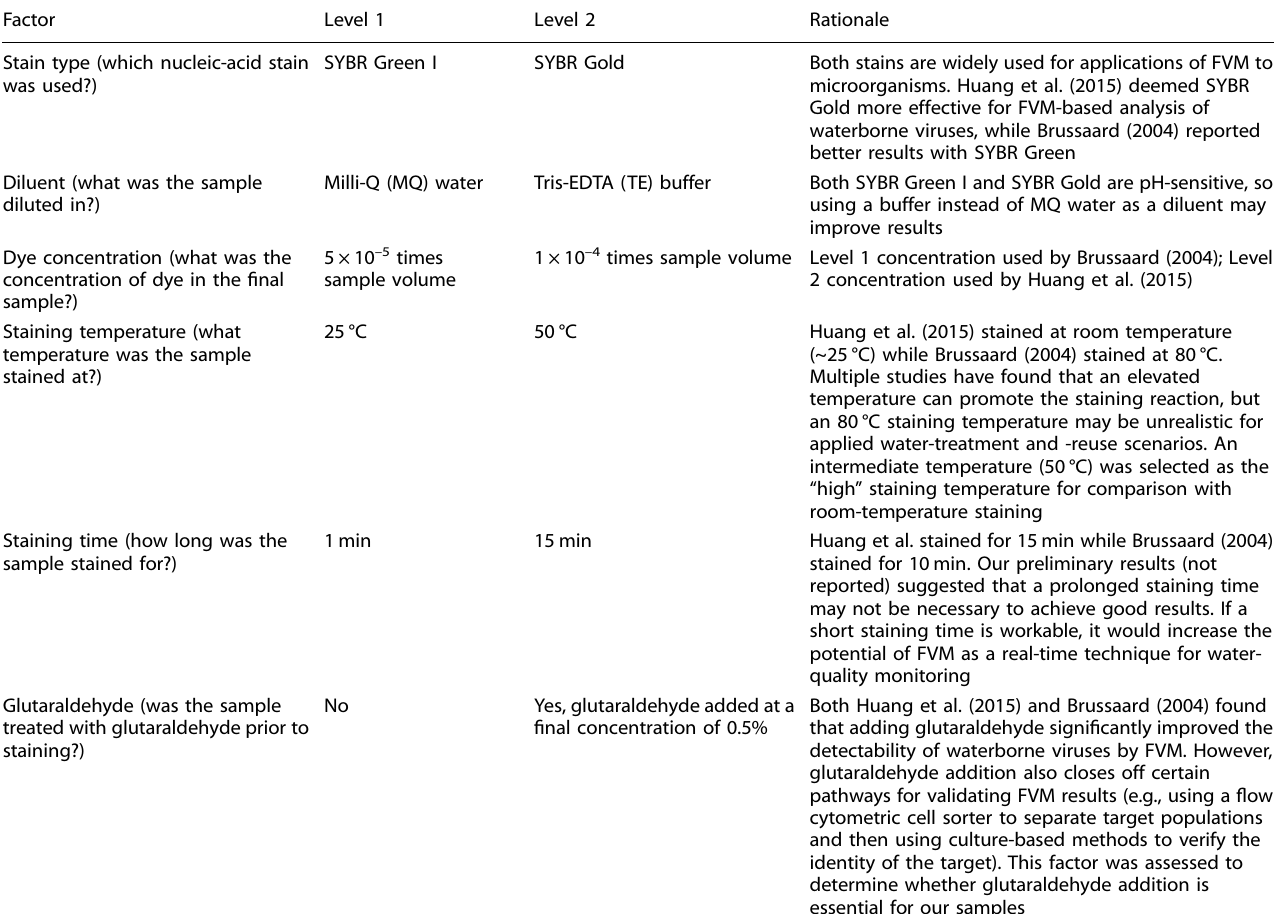
Table 1. Factors and levels included in the fractional factorial experimental design for staining